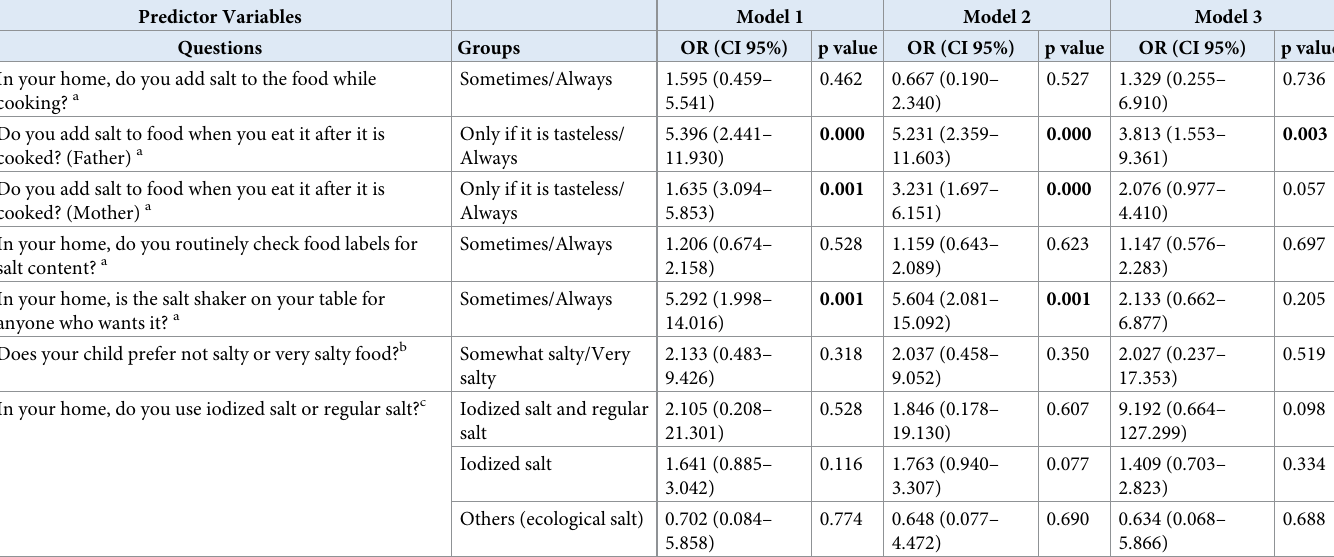
Table 4. Logistic regression models. Odds ratios and 95% confidence intervals for the child’s use of table salt sometimes/always versus never. Predictor